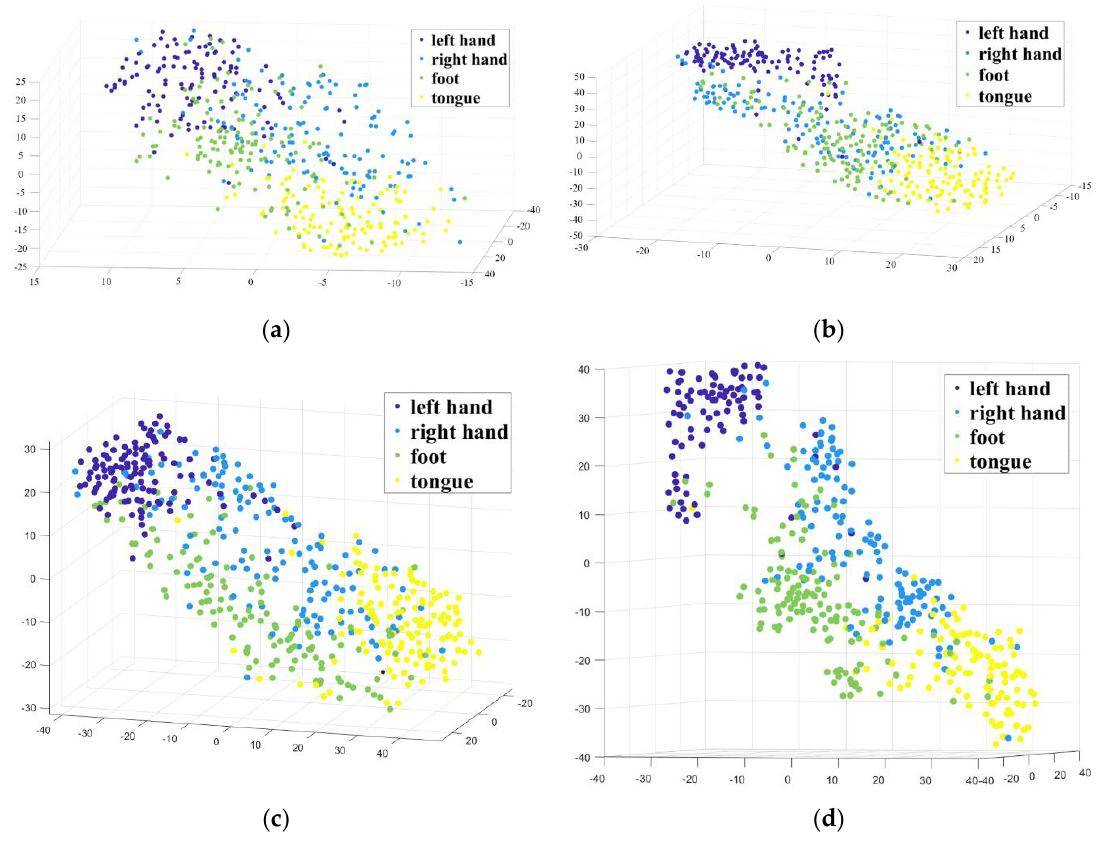
Figure 6. Visualization of single-view and multi-view features of EEG signals: ( a ) Single-view features of time domain signals; ( b ) Single-view features of frequency domain signals; ( c ) Single-view features of time-frequency domain signals; ( d ) Multi-view features.